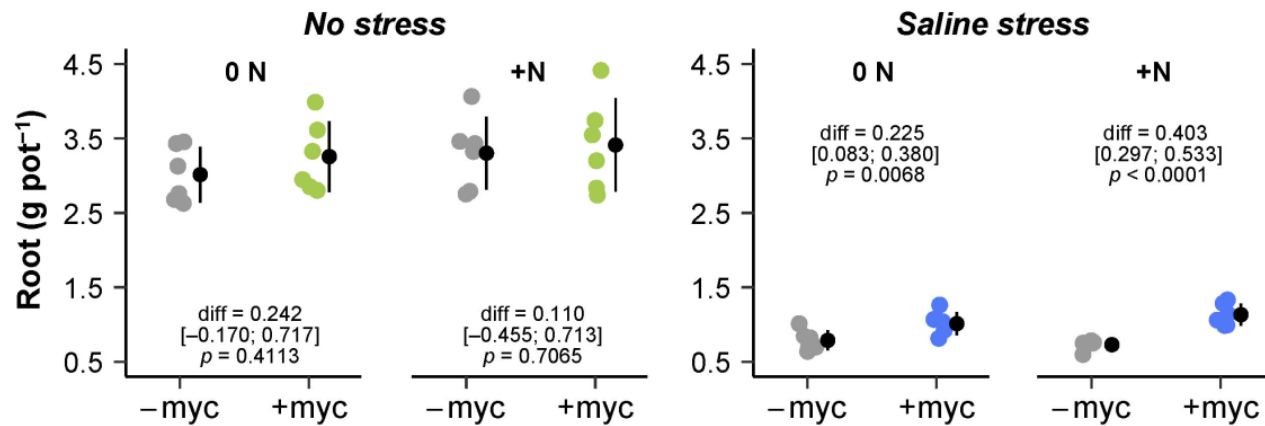
Figure 3. Root dry weight (g per pot) of durum wheat to varying treatments: no-stress or saline stress condition; N fertilization treatments (0 N, +N); absence or presence of arbuscular mycorrhizal fungal inoculum ( − myc, +myc). Black circles represent means, with whiskers representing ± SE ( n = 6). Differences (diff) between +myc and − myc means within the same fertilization treatment and the same saline treatment, estimated 95% confidence intervals of mean difference (in brackets), and p values are reported inside the plots.